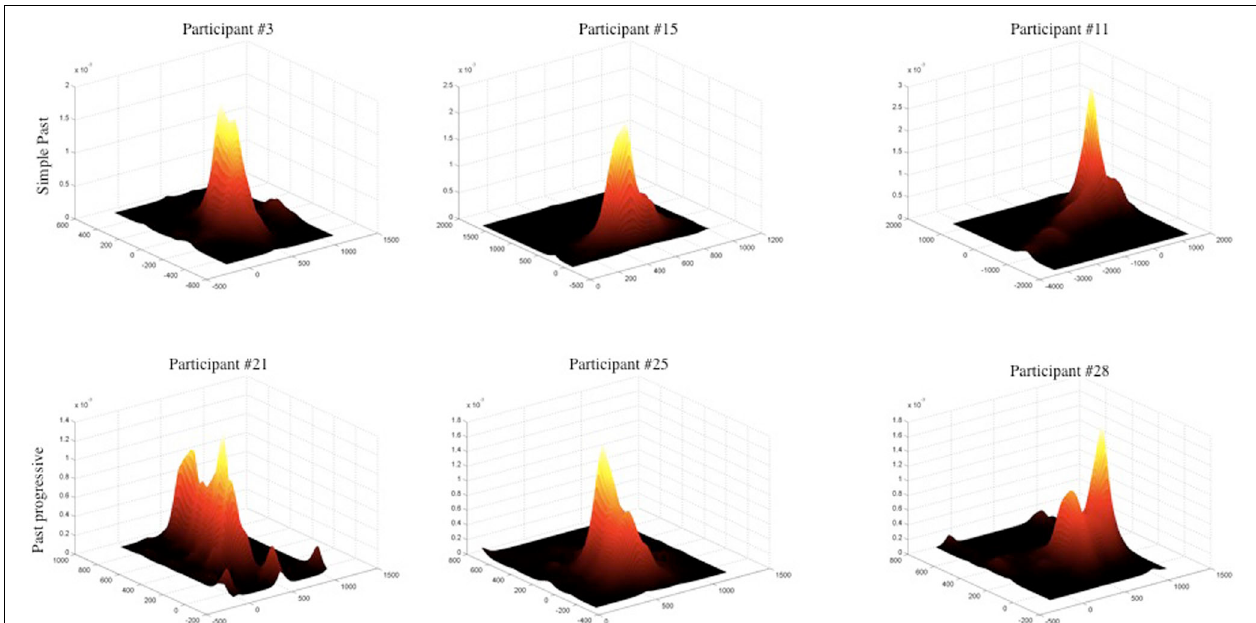
FIGURE 1 | Representative sample of individual fixation patterns, revealing a narrower spread of eye movements in the simple past condition (top row) as opposed to the past progressive condition (bottom row). The vertical axis shows total time spent fixating a given